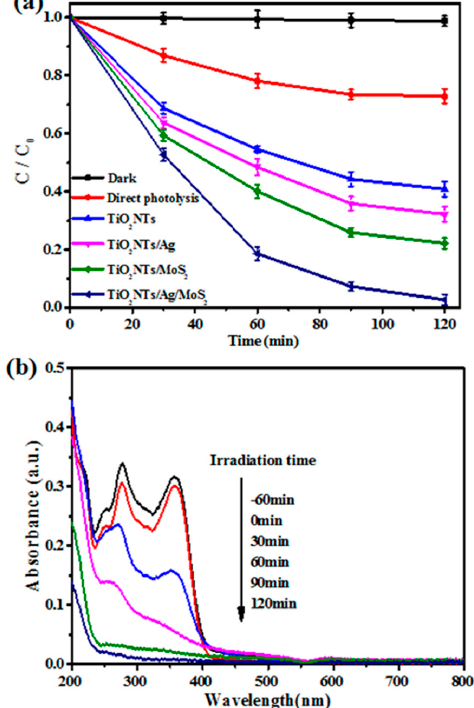
Figure 9. ( a ) The photoelectrocatalytic (PEC) efficiencies of TC · HCl under different conditions; ( b ) UV-vis absorption spectra for the degradation of TC · HCl on the TiO 2 NTs/Ag/MoS 2 . The PEC activity of the TiO 2 NTs/Ag/MoS 2 meshy photoelectrode was evaluated by applying different voltage of 0.05 V, 0.1 V, 0.2 V, 0.3V, and 0.5 V. As depicted in Figure S2a, the TiO 2 NTs/Ag/MoS